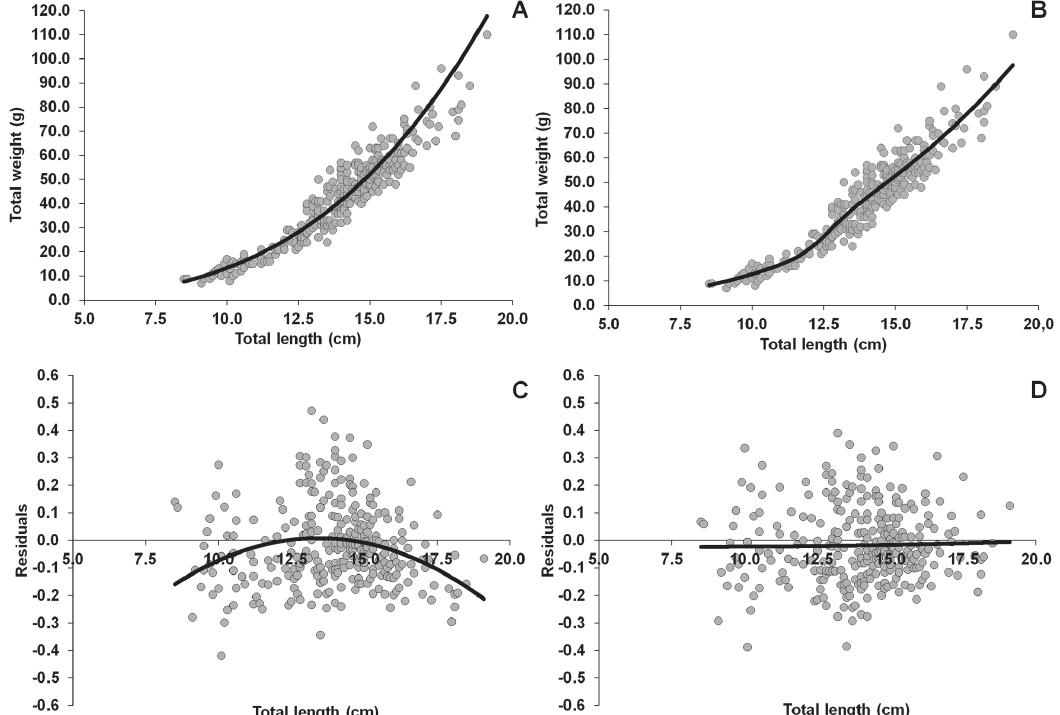
Fig. 3. Length/weight relationship of female Auchenipterichthys longimanus. A and C represent Huxley regular length/ weight relationship and its distribution of proportional residuals. B and D represent polyphasic length/weight relationship its and distribution of proportional